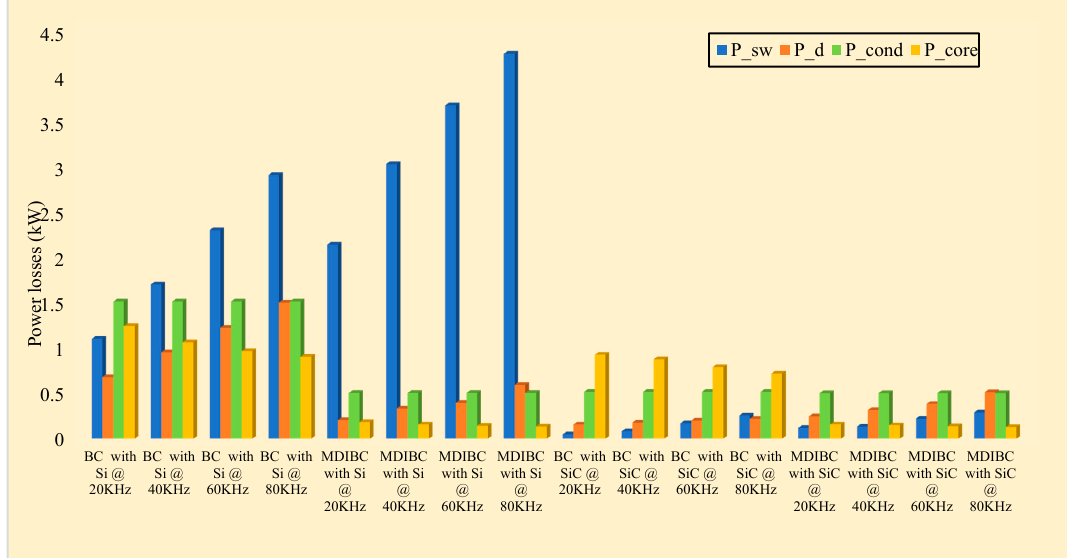
Figure 25 . Distribution of power losses of Si and SiC-based BC and MDIBC . Figure 25. Distribution of power losses of Si and SiC-based BC and MDIBC.